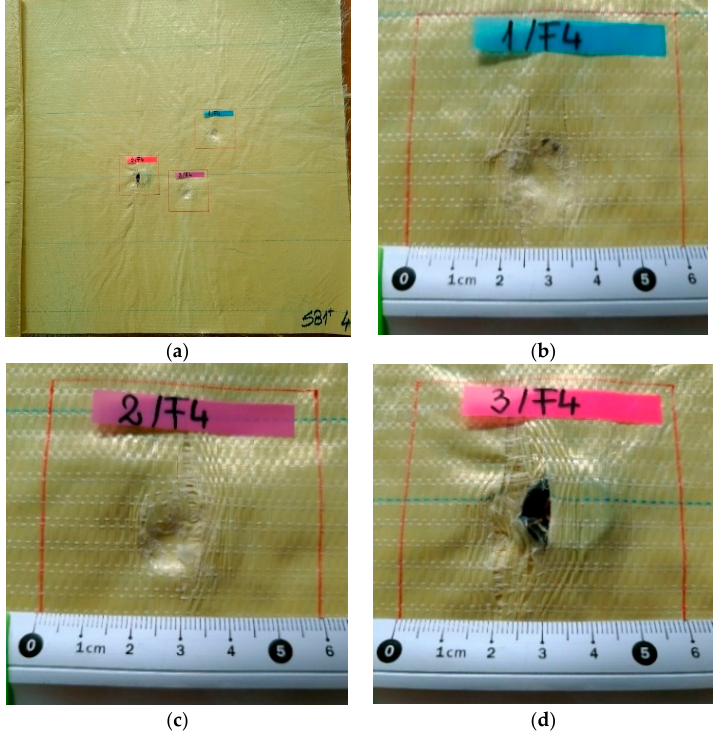
Figure 10. Front view of sample made of LFT SB1plus: ( a ) layer 4 (face), with details of the penetration: ( b ) fire 1, ( c ) fire 2 and ( d ) fire 3. Polymers 2021 , 13 , 2912 Layer 5 (Figure 11) shows traces of crushing (compression), circular in shape, which would be justified by the architecture of the LFT SB1plus semi-finished product (with the orientation of the yarns 0°/90°/45°/ − 45°), inducing a tendency to uniformity of the proper- ties of the fabrics in four sub-layers and, therefore, of its answer. Layers 6 and 7, theoretically, have the role of retaining (arresting) the projectile and dumping its tendency to advance together with the fabrics. These layers and the following ones are also responsible for reducing the BFS.